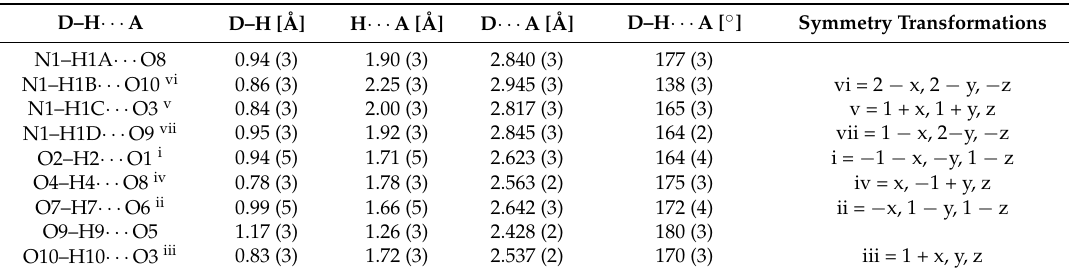
Table 1. Details of the hydrogen bonding interactions in 1 a